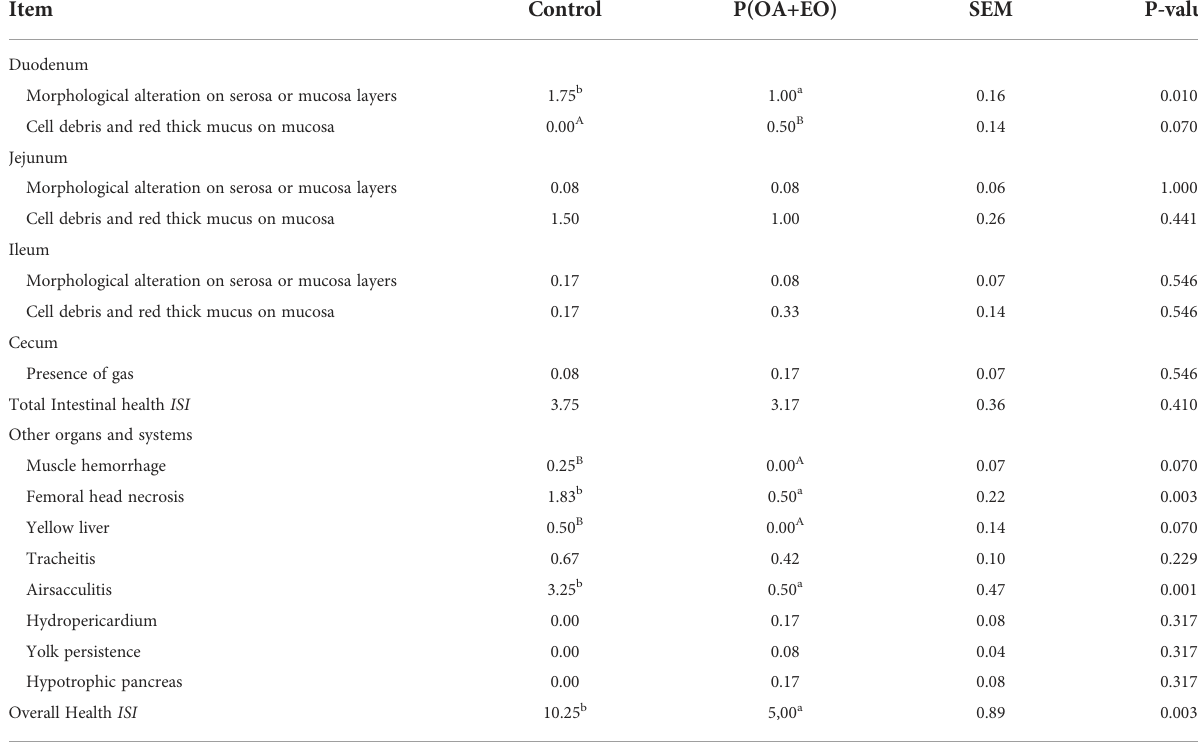
TABLE 2 Macroscopic intestinal and overall health – ISI score at 12 weeks of